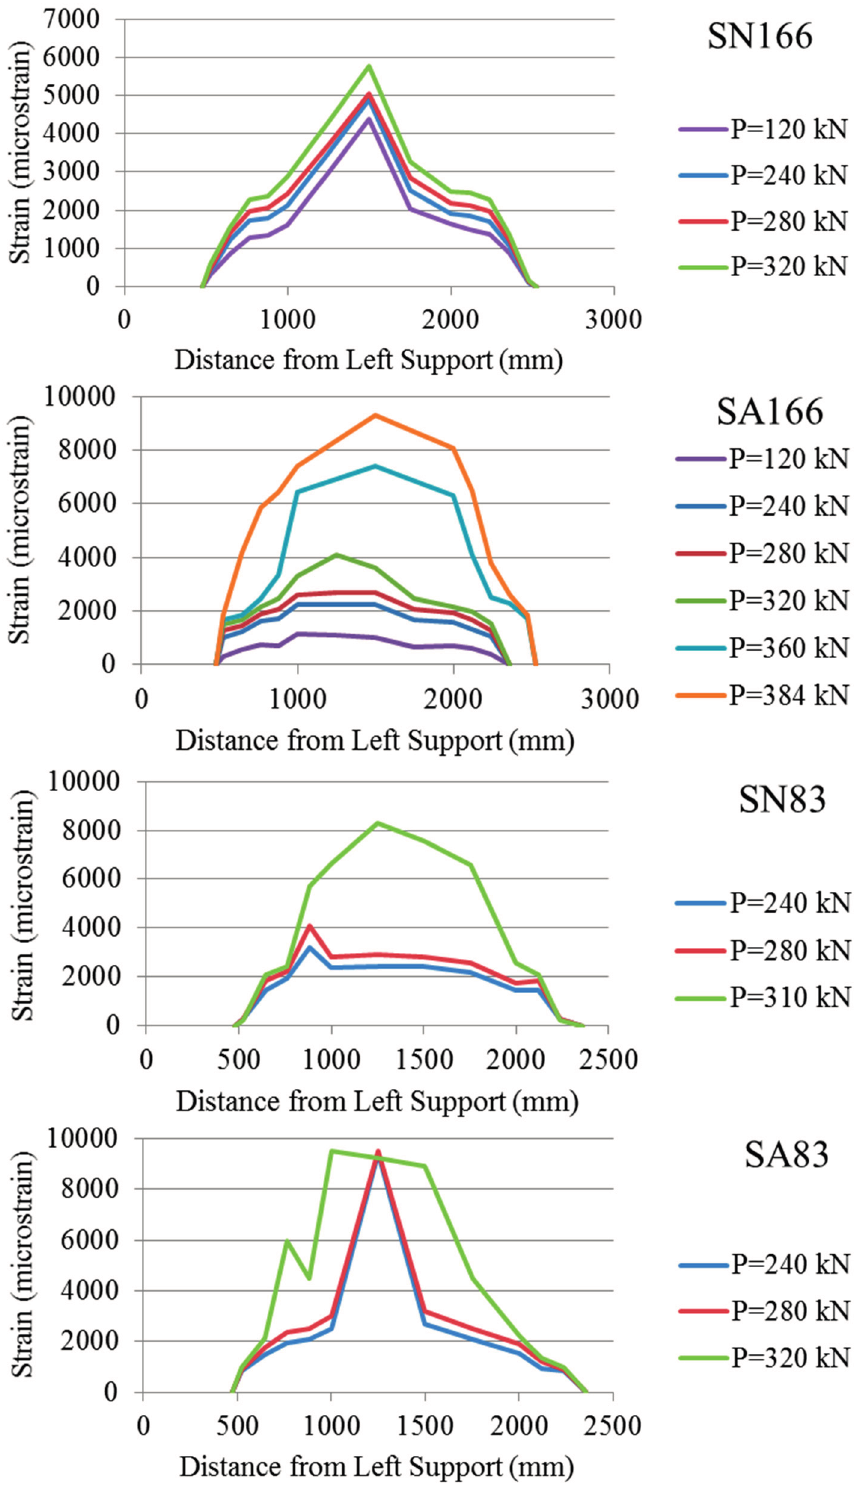
Figure 9. Strain variation along the FRP sheet in beams with and without